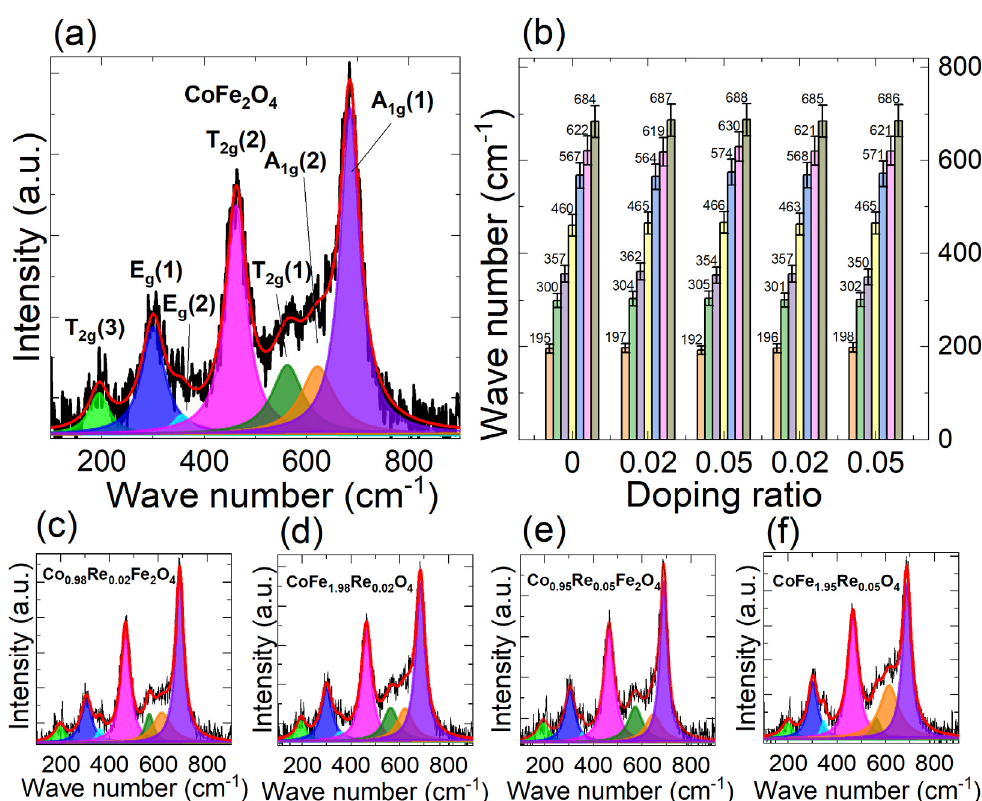
Figure 5. Room temperature Raman spectra and the fitting result of ( a ) CoFe 2 O 4 , ( c ) Co 0.98 Re 0.02 Fe 2 O 4 , ( d ) Co 0.95 Re 0.05 Fe 2 O 4 , ( e ) CoFe 1.98 Re 0.02 O 4 , and ( f ) CoFe 1.95 Re 0.05 O 4 nanoparticles excited by a 0.17 mW 532 nm laser. ( b ) Evolution of the fitting peak intensity and position with the Re doping ratio. The spectra verify the inverse spinel phase, and the peak positions of the A 1g (685 cm − 1 ), T 2g (2) (460 cm − 1 ), and E g (300 cm − 1 ) modes increase with Re doping, while the positions fluctuate for other modes, indicating a different presence of cations.